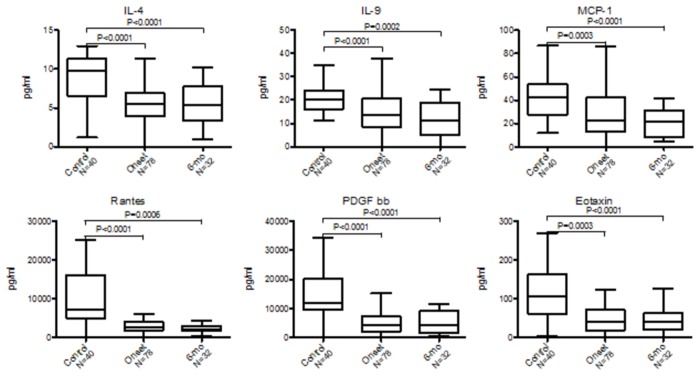
Immune analytes concentrations differentially distributed among control, DILI onset and 6-month follow up samples.Box-and whisker plot: Turkey representation (i.e. 25-75 percentile +/- 1.5 interquartile distance) of immune analytes concentration in sera collected from control, DILI onset and 6-month follow up. Immune analytes measurements are in pg/mL. * Comparisons of all distributions to control samples are statistically significant (p<0.05) by Wilcoxon rank sum test. § Comparisons of the difference between DILI onset and 6-month follow up distributions are statistically significant (p<0.05) by paired t-test or Wilcoxon rank sum test.